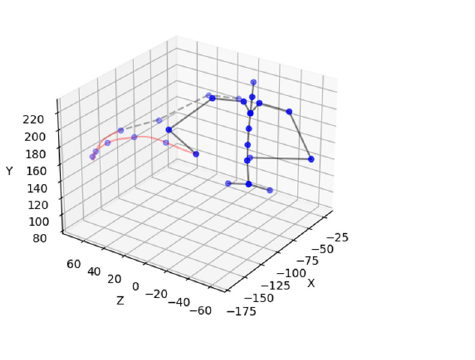
Figure 6. Image representing the skeleton data used for training the NN model and the sliding win- dow approach: ( a ) view of the skeleton data with the points and motion data for one point (a hand motion is presented in this example); ( b ) hand motion presented as timeseries.